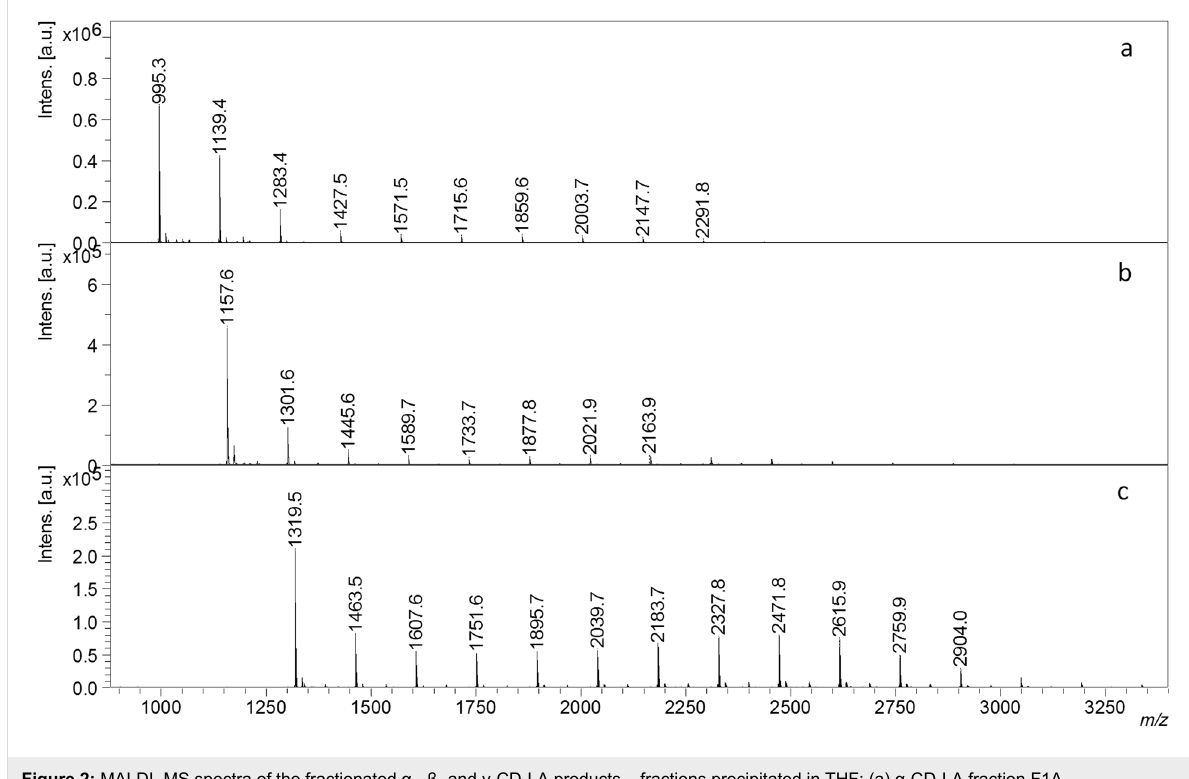
Figure 2: MALDI–MS spectra of the fractionated α -, β - and γ -CD-LA products – fractions precipitated in THF: (a) α -CD-LA fraction F1A, (b) β -CD-LA fraction F1B and (c) γ -CD-LA fraction F1C.